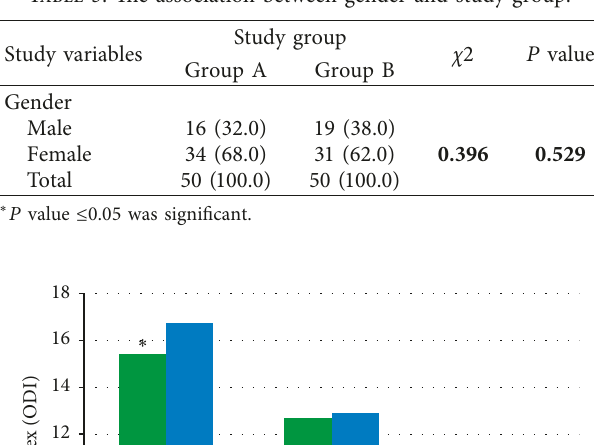
Table 3: The association between gender and study group.